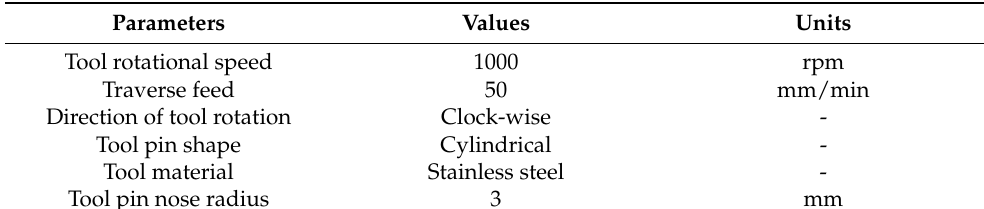
Table 4. Process parameters in Friction Stir Welding.